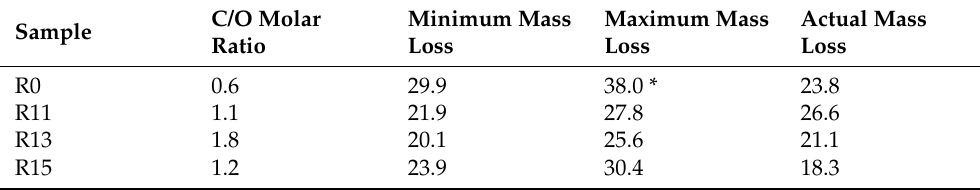
Table 5. C/O molar ratio, minimum and maximum mass loss and the experimental mass loss.